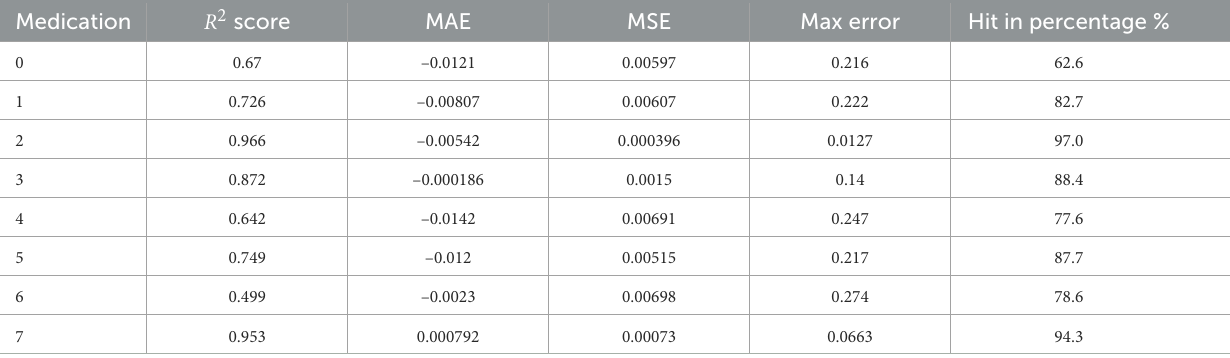
TABLE 5 Statistics of the TDA method.